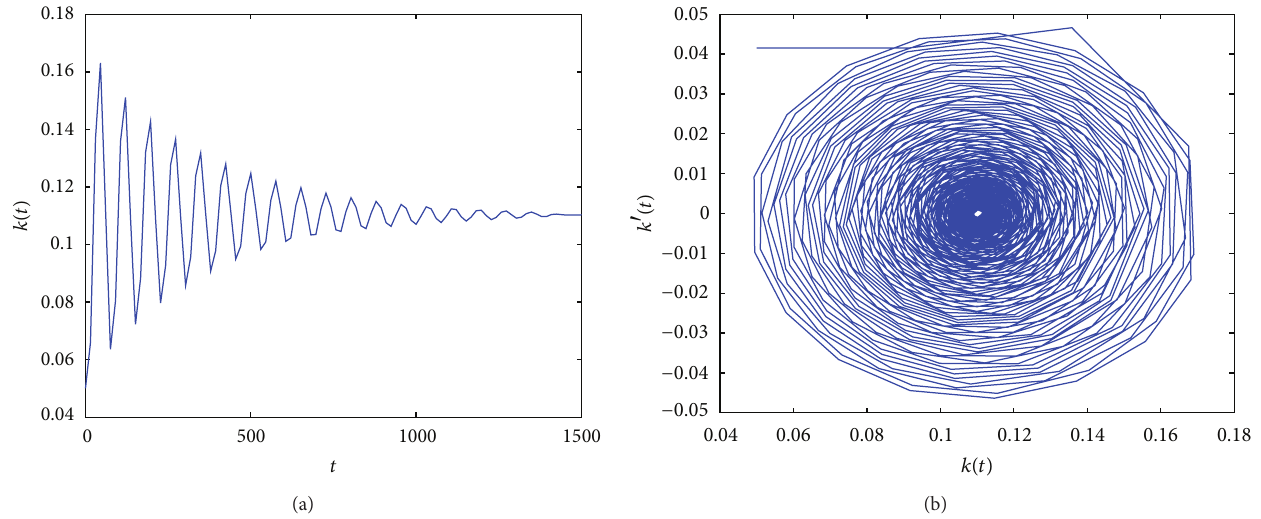
Figure 3: The time evolution of the function 𝑘(𝑡) for 𝑠 = 0.11 , 𝛿 = 0.8 , 𝛼 = 0.1 , 𝐴 = 1 , 𝜏 1 = 1 , and 𝜏 2 = 2 (a). The 𝑘 󸀠 (𝑡) versus 𝑘(𝑡) , for 𝑡 ∈ [0, 1300]